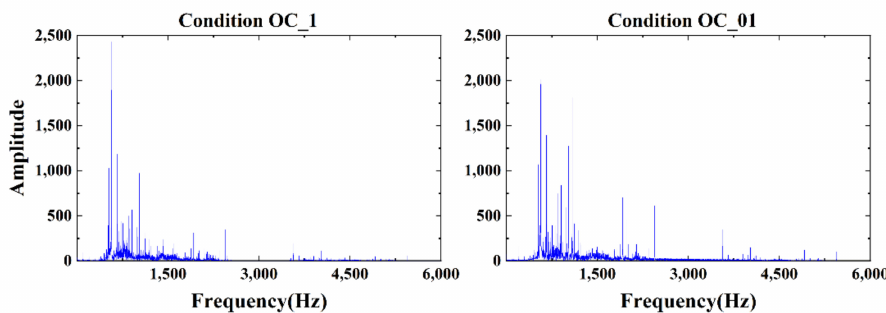
Figure 13. Frequency domain waveform diagram of bearing load after wavelet noise